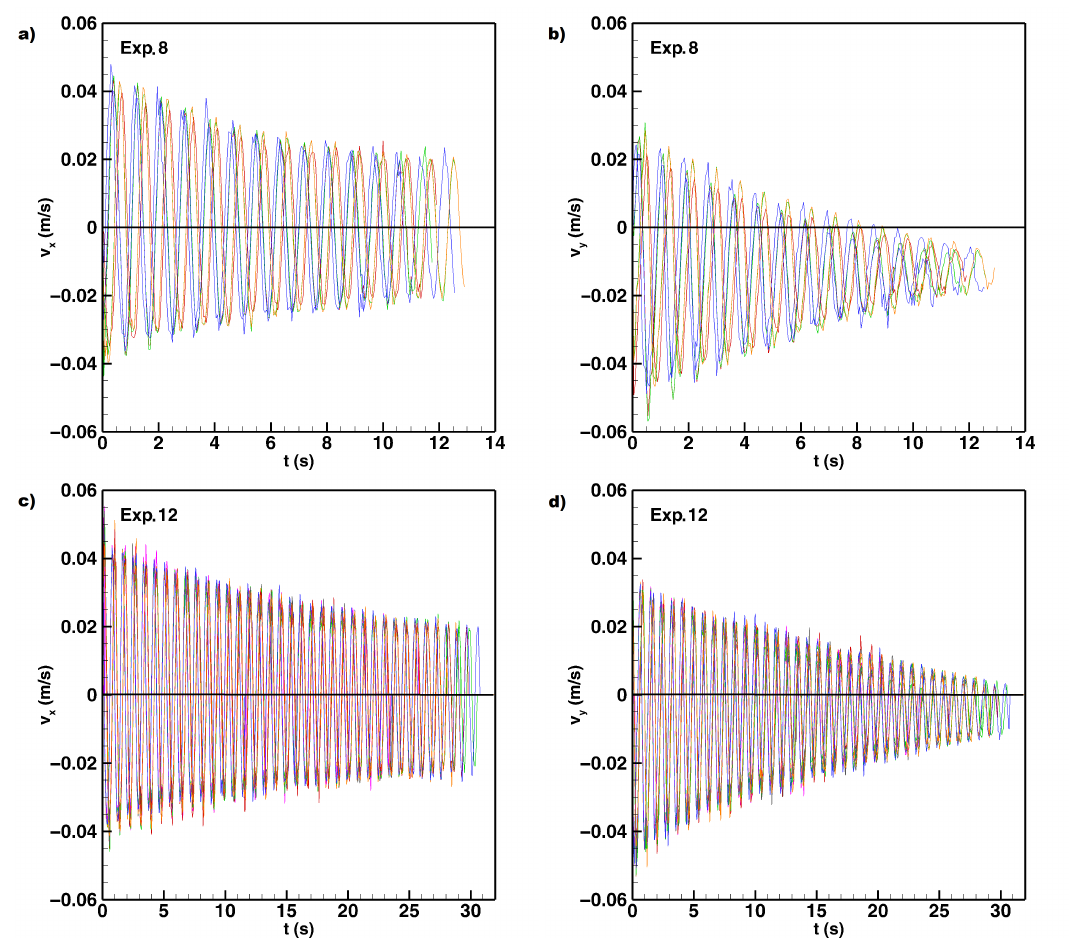
Figure 4. Time evolution of the particle velocities: ( a ) Experiment 8 x-component, ( b ) Experiment 8 y-component, ( c ) Experi- ment 12 x-component, and ( d ) Experiment 12